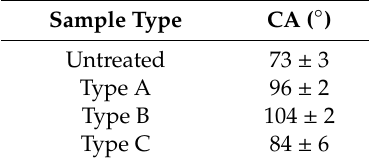
Table 2. Apparent contact angle (CA) for samples untreated and treated as